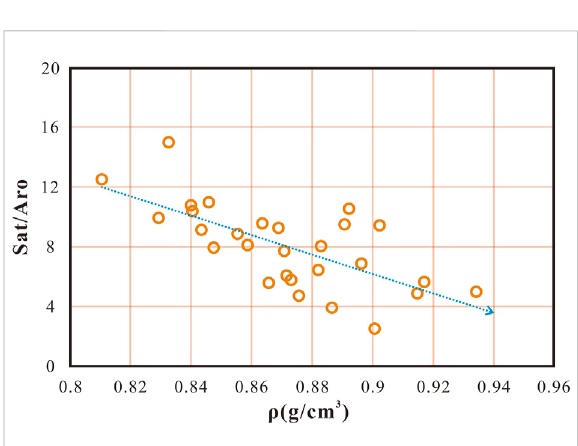
FIGURE 6 Plot of density ( ρ ) versus saturated/aromatic hydrocarbon ratios (Sat/Aro) from the studied Carboniferous crude oil samples in the Hongche fault